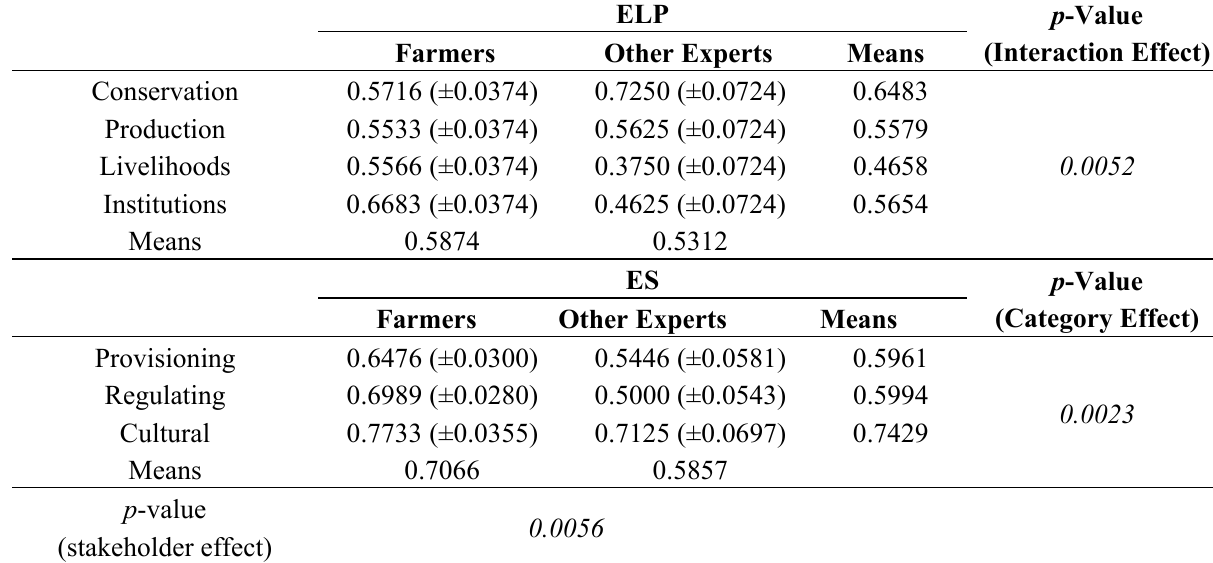
Table 5. Means of ELP and ES sub-index values at the SVC site (standard deviation in brackets). ES, Ecosystem Services; ELP, Ecoagriculture Landscape Performance; SVC, Savé Valley